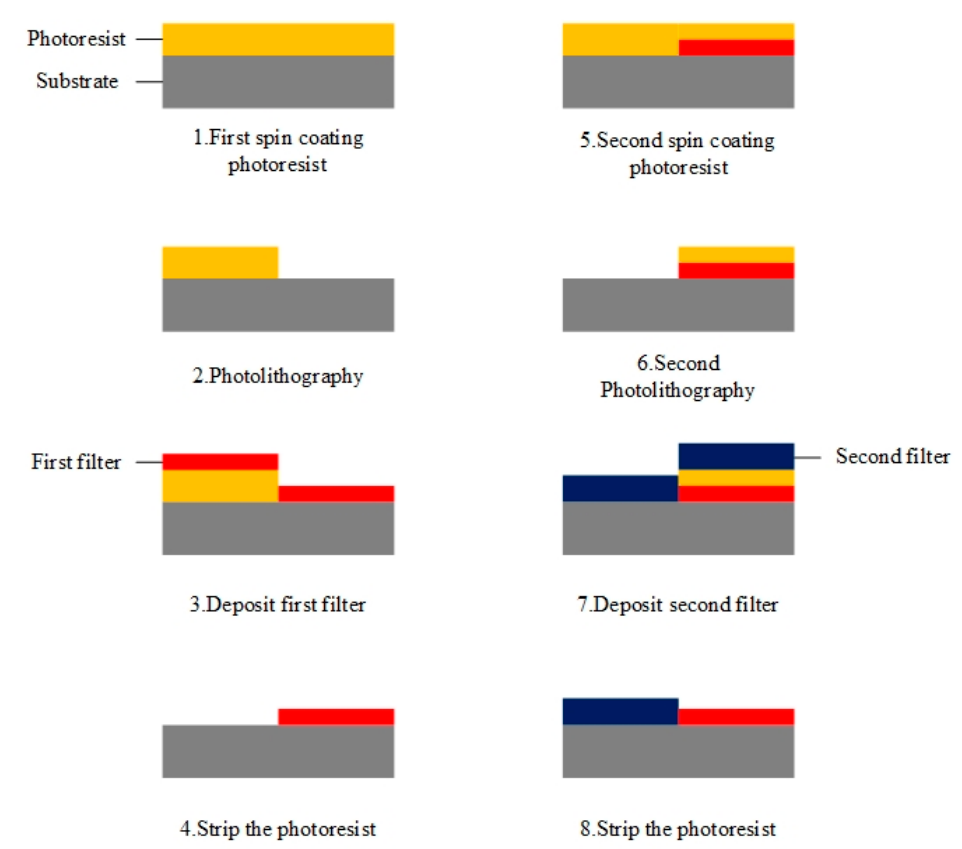
Figure 5. The schematic diagram of detailed lift-off process steps .